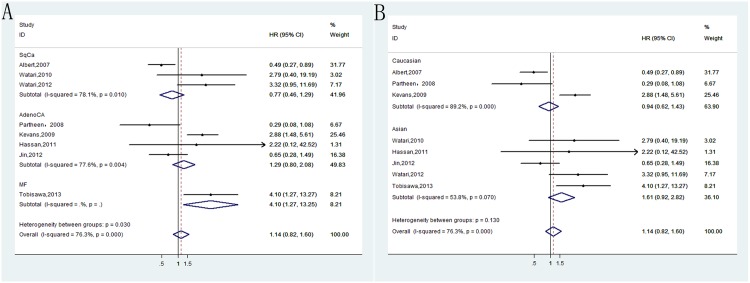
Subgroup analyses of group 2.(A) shows the pathology-type subgroup analysis, and (B) shows the ethnicity subgroup analysis.